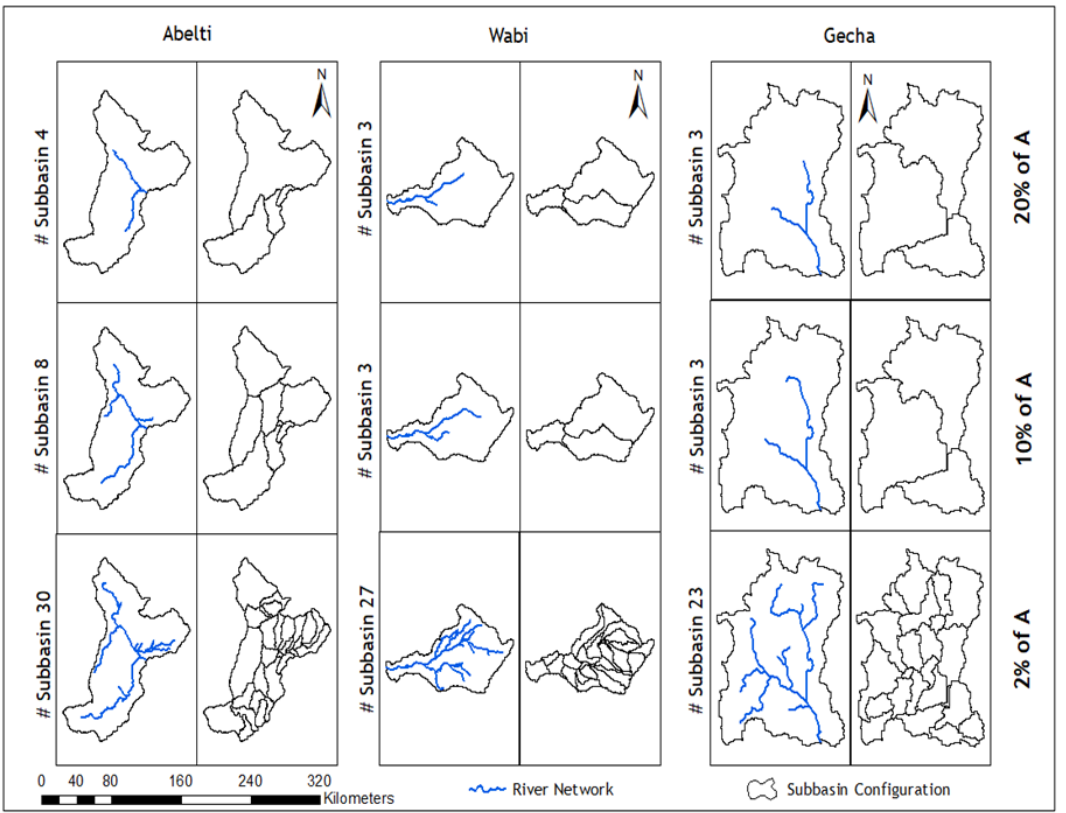
Figure 2. Three subbasin subdivision levels for the study area (Abelti, Gecha and Wabi watersheds). (Note: A = watershed